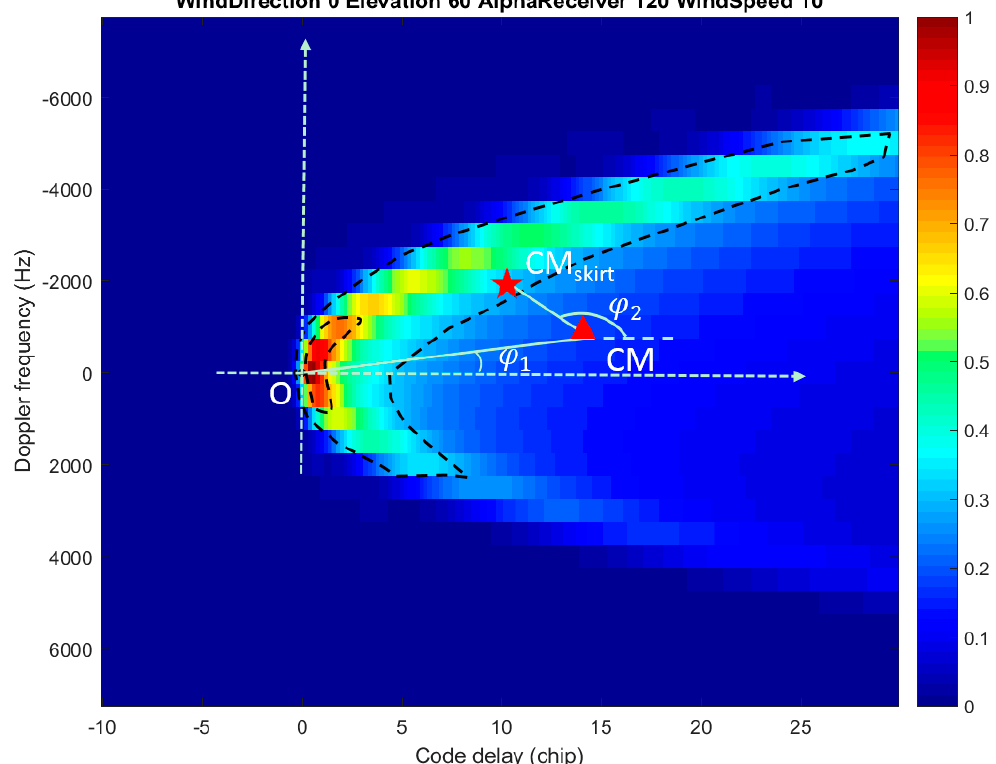
Figure 3. Definition of two metrics: (1) ϕ 1 , the azimuth of vector pointing from the specular point to the center of mass (CM, red triangle); (2) ϕ 2 , the azimuth of vector pointing from the center mas (CM) to center of mass of Delay Doppler map (DDM) skirt (CM skirt , red pentagram). The DDM is simulated under wind direction 0°, elevation 60°, azimuth 120°, and wind speed 10 m/s, and is normalized to the peak of DDM. The region surrounded by the black dash lines is the DDM skirt, whose normalized power ranges from 0.3 to 0.7.